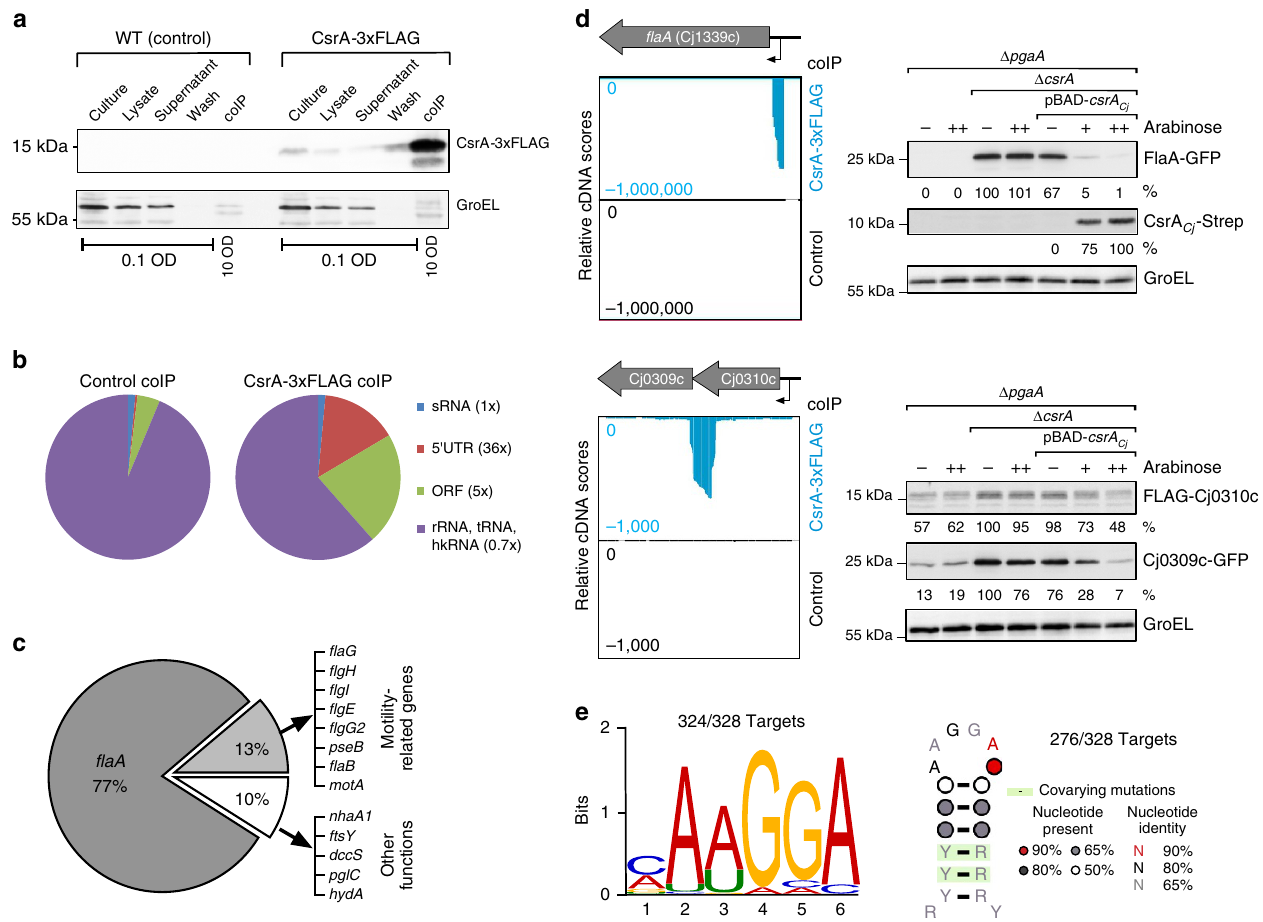
Figure 1 | RIP-seq analysis of C. jejuni CsrA. ( a ) Western blot analysis of coIP samples of C. jejuni NCTC11168 WT and csrA- 3xFLAG strains using anti- FLAG antibody confirms a successful CsrA-3xFLAG pulldown in the tagged strain. The amount of samples loaded (OD 600 of bacteria) is indicated. GroEL served as loading control. ( b ) Pie charts showing relative proportions of mapped cDNA reads of different RNA classes in the coIP libraries (hkRNA: housekeeping RNAs). Numbers in brackets indicate the relative enrichment of the respective RNA class in the CsrA-3xFLAG versus control coIPs. ( c ) Pie chart showing the percentages and enriched genes of mapped reads for all 4 5-fold enriched CsrA target genes. ( d ) (Left) Mapped RNA-seq reads for the control (black) and CsrA-3xFLAG coIP (blue) in strain NCTC11168. Grey arrows: ORFs; black arrows: transcriptional start sites (TSS). Examples of enrichment patterns in 5 0 UTRs ( flaA ) and between genes in a polycistron (Cj0310c-Cj0309c operon; encoding two paralogous efflux proteins). (Right) Western blot analysis using anti-FLAG and anti-GFP antibodies of reporter fusions to potential C. jejuni CsrA target genes in E. coli D pgaA , D pgaA / D csrA and D pgaA / D csrA þ pBAD- csrA Cj (complementation with C. jejuni CsrA-Strep under control of an arabinose-inducible pBAD promoter) strains. Putative CsrA targets from C. jejuni were fused in-frame (for example, 33 aa for flaA ) to GFP or a FLAG- lacZ’ tag (Supplementary Fig. 4b). As deletion of csrA dramatically enhanced biofilm formation and led to poor growth in liquid culture in our E. coli strain, reporter experiments were performed in a D pgaA background. GroEL served as loading control. Protein samples corresponding to 0.1 OD 600 were loaded. Quantifications of reporter expression are given below the blots. ( e ) (Left) CsrA-binding motif predicted by MEME 24 ( E -value ¼ 2.1E-11). (Right) Consensus secondary structure motif of C. jejuni CsrA-binding sites predicted by CMfinder 62